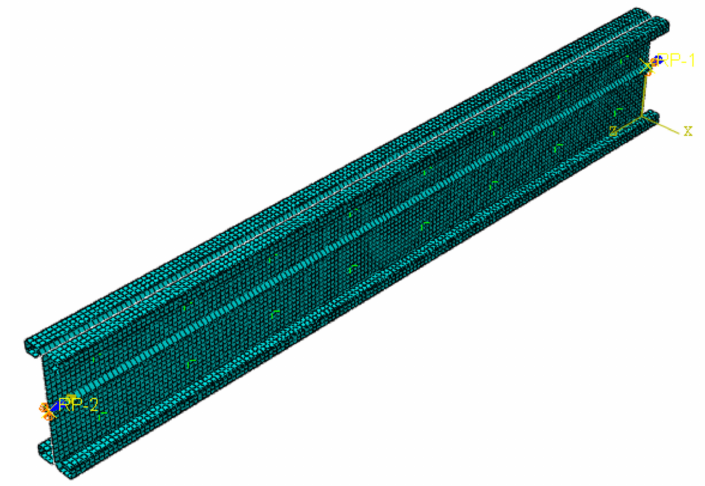
Figure 10. FE meshing for BISCS-5.